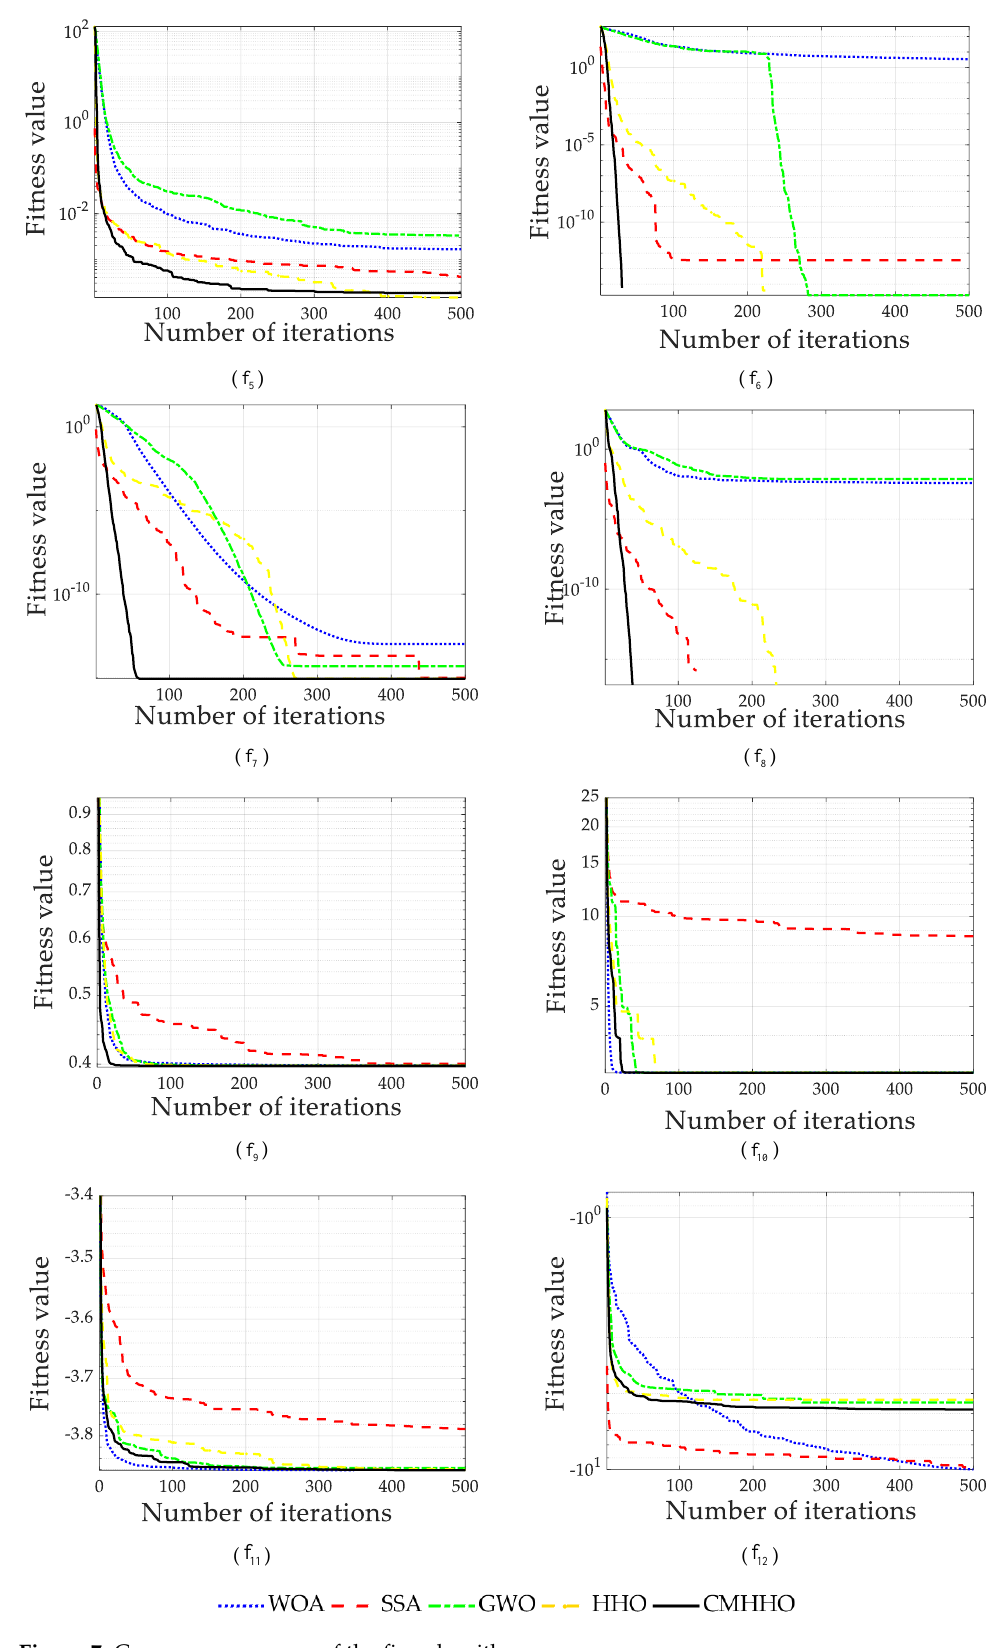
Figure 7. Convergence curves of the five algorithms.